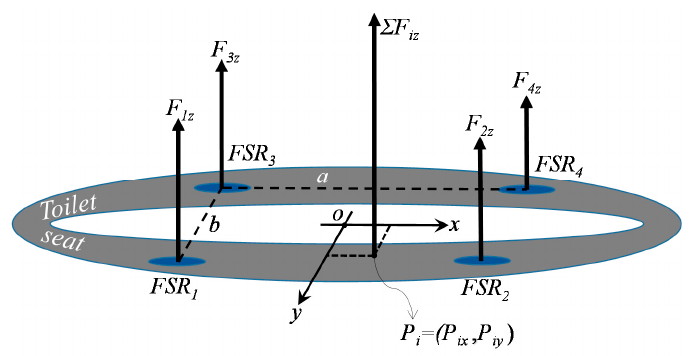
Figure 5. P i location of the center of pressure on the sole in both directions.